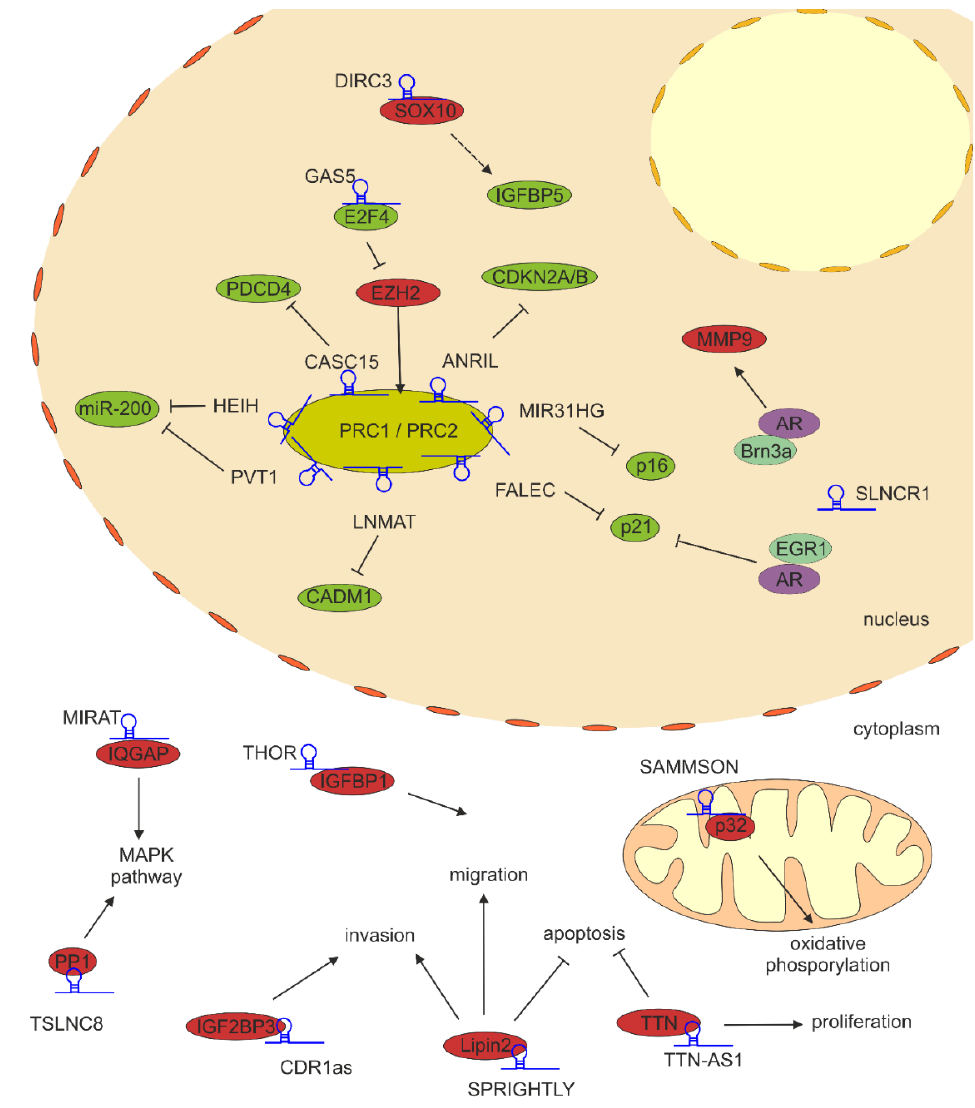
Figure 2. lncRNA-protein interactions in melanoma cells. The mechanism of action and function of various lncRNAs is predominantly imposed by their subcellular localization. lncRNAs can reside in the nucleus, where they bind to activators or repressors of transcription, as well as to transcription factors, thereby regulating the expression of target genes. Cytosolic lncRNAs modulate signaling pathways that control melanoma cell proliferation, invasion and migration. Mitochondrial lncRNAs control oxidative phosphorylation and sensitivity to apoptosis. Dashed arrow indicates indirect activation of expression.